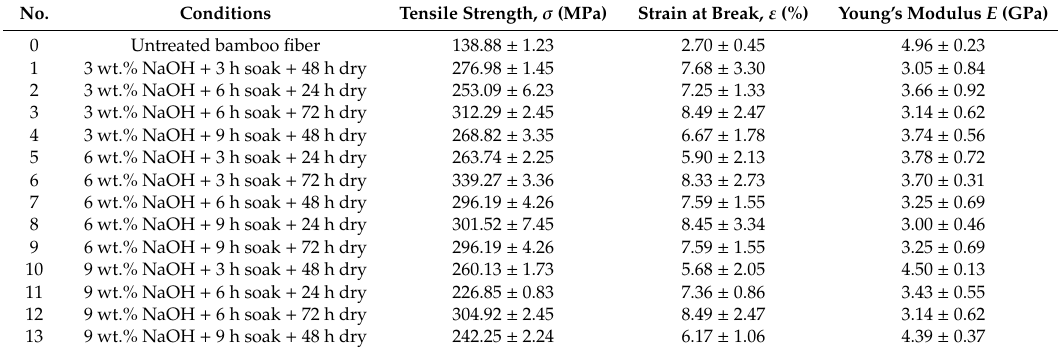
Table 3. Alkaline treatment conditions and test results for bamboo reinforced epoxy